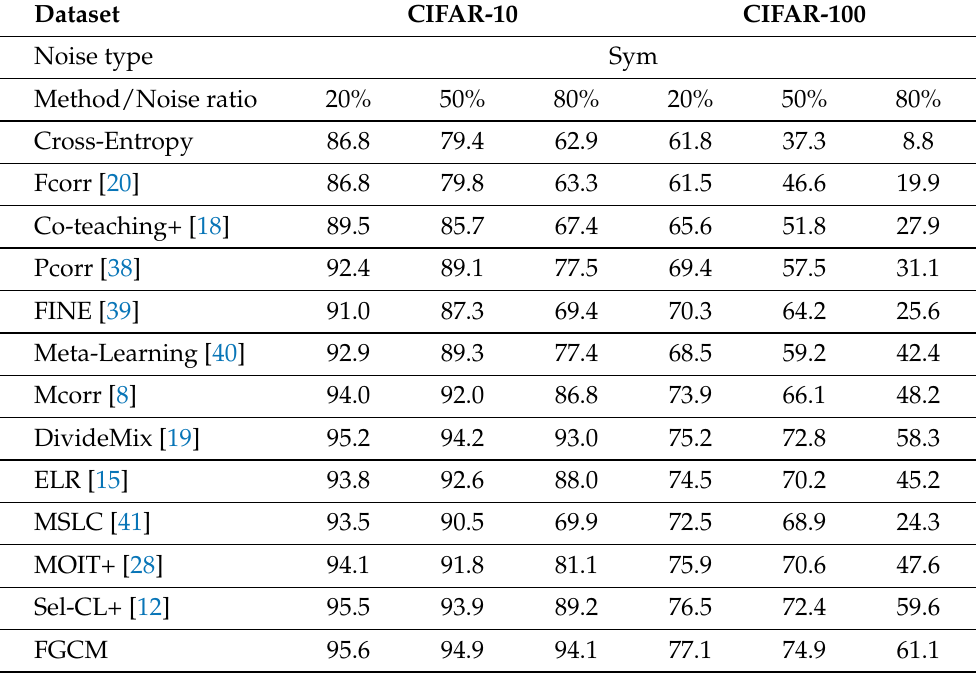
Table 2. Performance comparison with state-of-the-art methods on CIFAR-10 and CIFAR-100 with different ratios of symmetric noise as PreAct-18 resnet being the